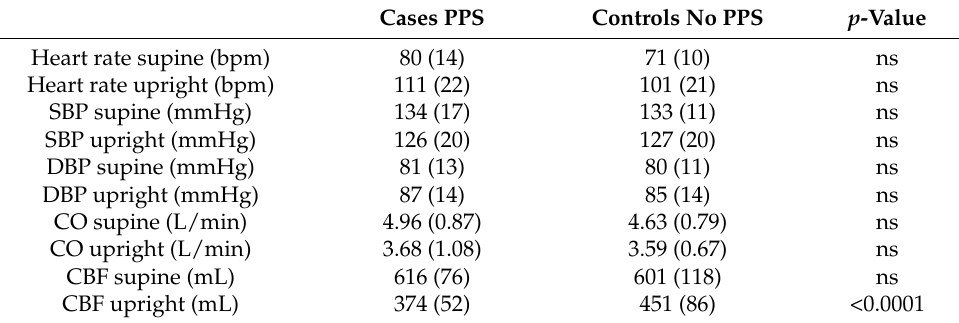
Table 1. Hemodynamic tilt test characteristics.